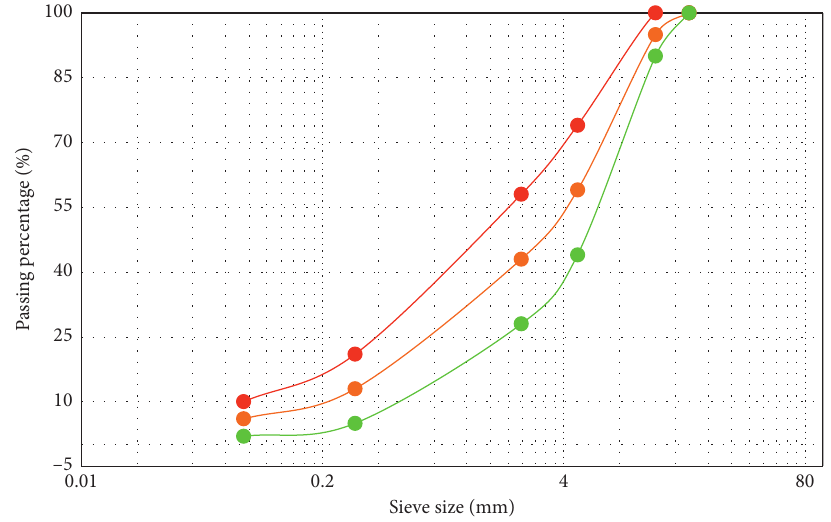
Figure 2: The grading of aggregates applied in the